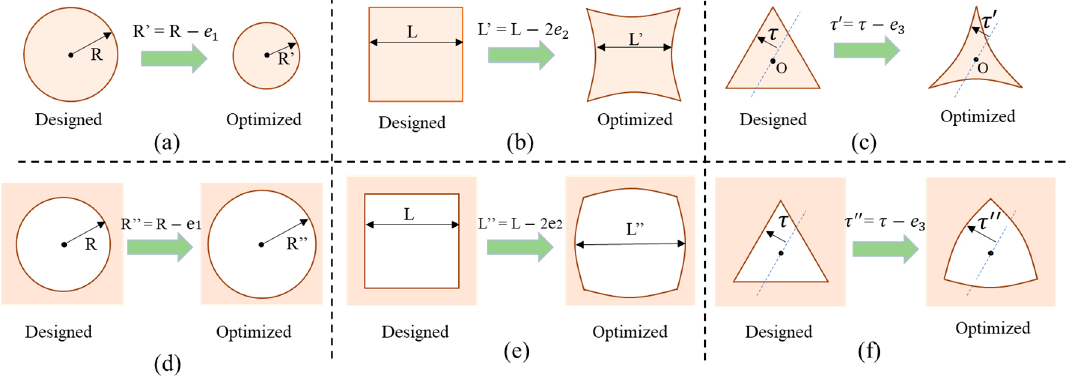
Figure 5. The compensation strategy based on the structure optimization. ( a ) The circle pattern, ( b ) the square pattern, ( c ) the triangle pattern, ( d ) the pattern for the circular hole, ( e ) the pattern for the square hole and ( f ) the pattern for the triangular hole.